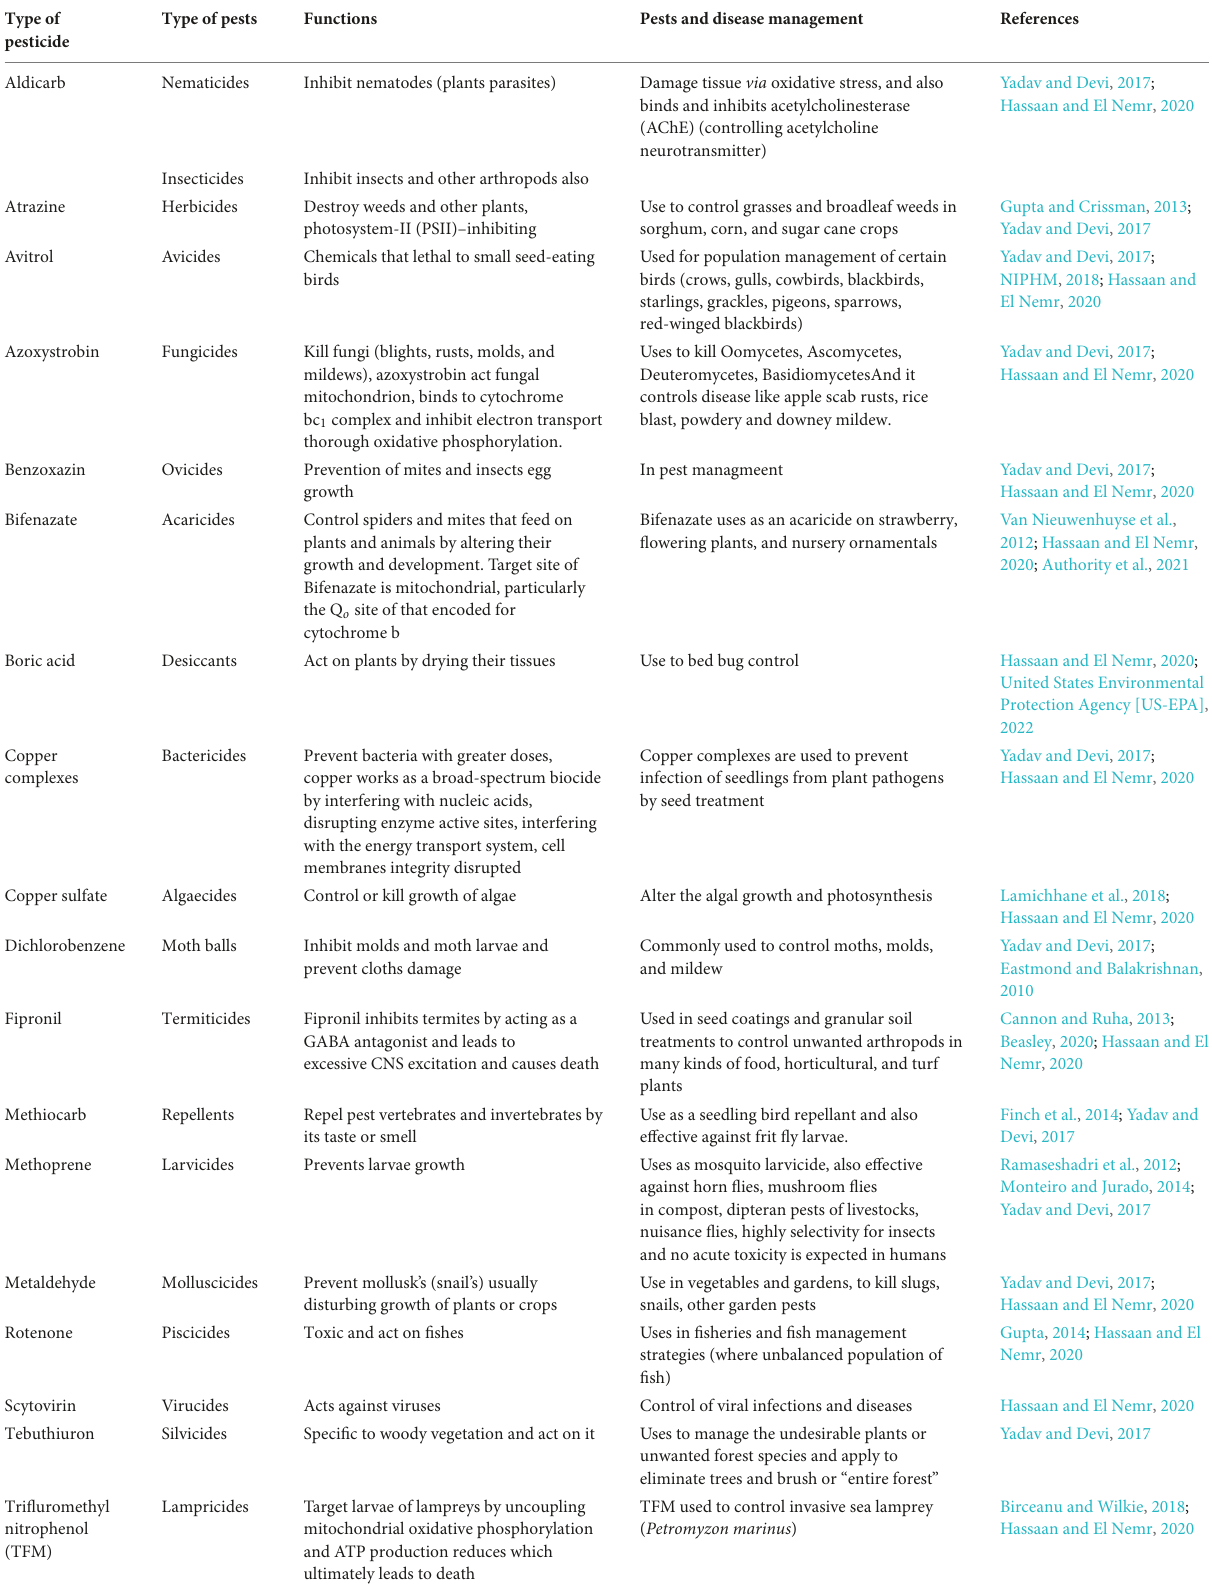
TABLE 4 Pesticides classification according to pest type, functions, and management